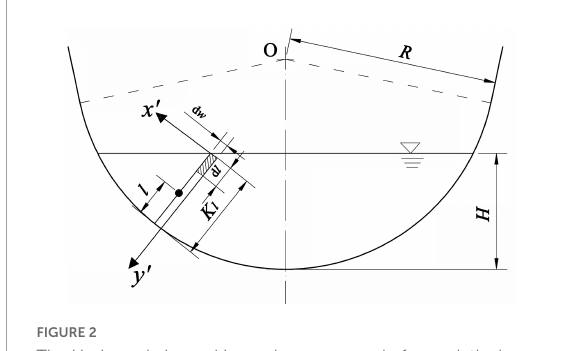
FIGURE2 The U-shaped channel is used as an example for analytical derivation. In a U-shaped channel with radius R and maximum water depth H , take a normal line passing through the center of the circle, and the length under the water surface is K l